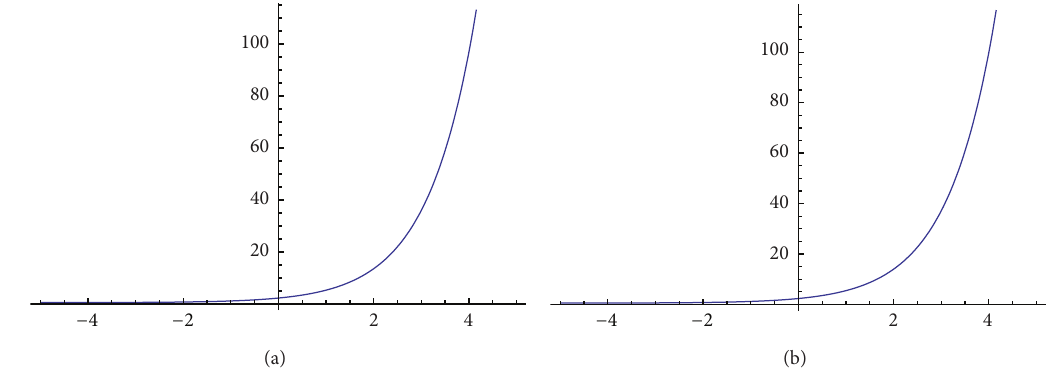
Figure 14: Two-dimensional graph of the solution (47) corresponding to the values 𝛼 = 0.05 , 𝛼 = 0.85 , respectively, when 𝑘 = 1 , 𝑎 0 = 1 , = 2 , 𝑡 = 1 , and −5 < 𝑥 < 5 𝑏 0